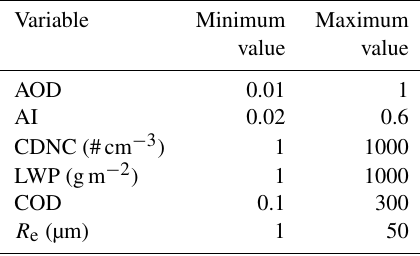
Table 1. Minimum and maximum values for aerosol and cloud properties used in this study. AOD is aerosol optical depth, AI is aerosol index, CDNC is cloud droplet number concentration, LWP is liquid water path, COD is cloud optical depth and R e is cloud droplet effective radius. CDNC and R e are cloud-top